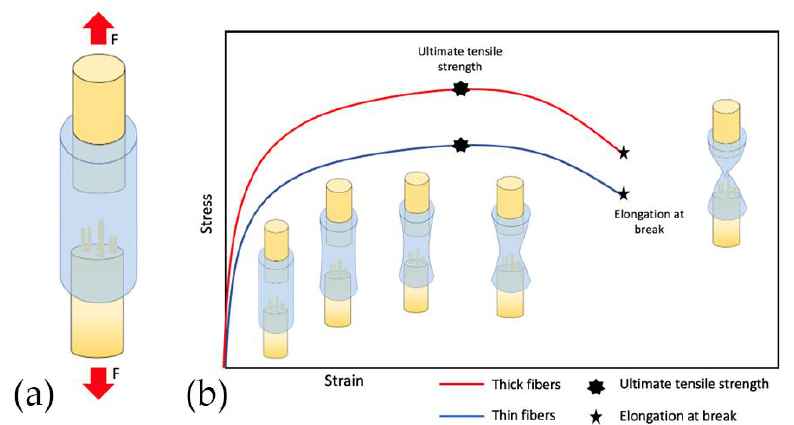
Figure 7. The schematic diagram for the stress–strain curve of NGC. ( a ) The arrows indicate the orientation of the applied force. ( b ) The uphill slope represents the increase in traction in the NGC. Ultimate tensile strength is the maximum in the curve, which means the maximum tension that the NGC can sustain in tension. The downward slope of the curve after UTS is caused by the instability caused by the reduction of the cross-section, which will lead to the break of NGC represented with EB. Coarse fibers have significantly higher ultimate tensile strength (UTS) and elongation at break (EB).